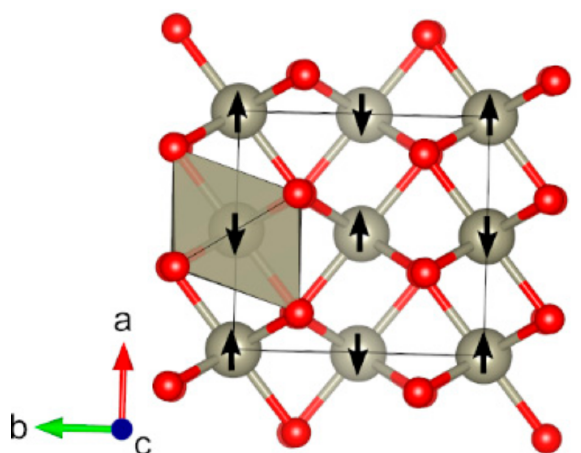
Figure 10. Optimized structure of ReO 2 ( mP12 ) (red: O, grey: Re). The directions of magnetic moments are illustrated by black arrows. Coordination octahedra of Re atoms is shown in grey